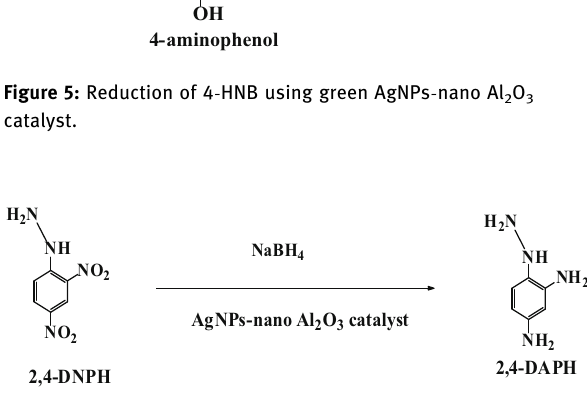
Figure 6: Reduction of 2,4 - DNPH using green AgNPs - nano Al 2 O 3 catalyst.